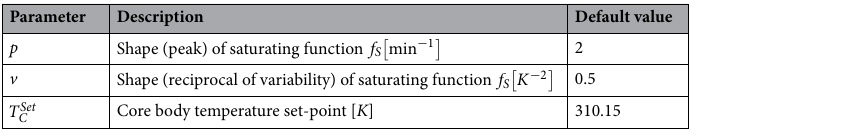
Table 3. Parameters for saturating function f s